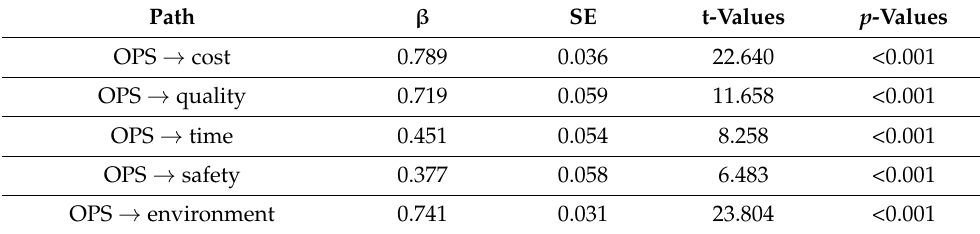
Table 9. Bootstrapping statistics for reflective